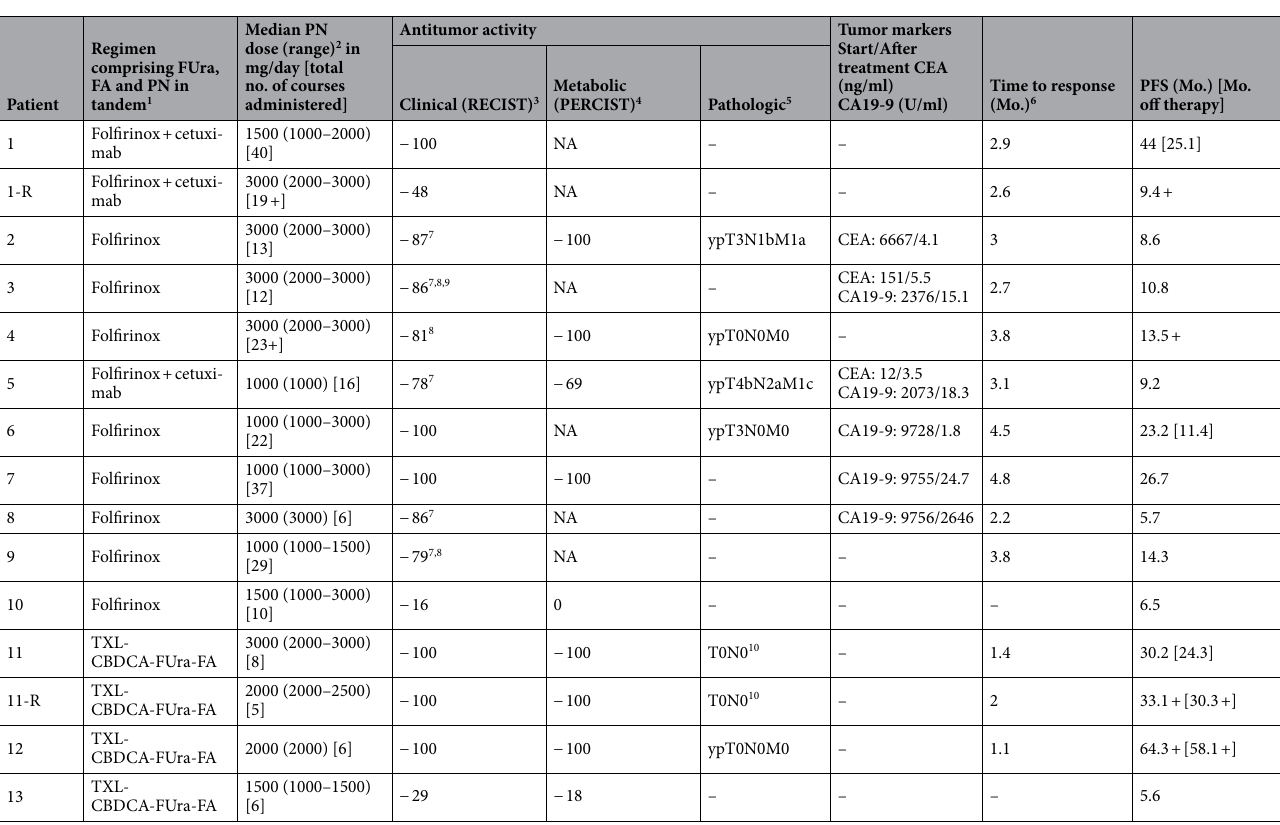
Table 2. Results of therapy in patients treated with regimens comprising 5-fluorouracil, folinic acid, and pyridoxine in tandem. 1 In patients treated with Folfirinox who required suspension of the L-OHP due to peripheral neuropathy, chemotherapy was pursued as Folfiri. 2 Range represents the intra-patient dose escalation of PN preceding each injection of FUra and FA given for a number of days defined by the chemotherapy regimen used. 3 Percent variation in sum of greatest diameters was assessed by CT scan, MRI, and endoscopic ultrasonography (EUS) imaging when required. For patients who attained a response accompanied by disappearance of most metastases, RECIST values were calculated by size comparison of persisting tumors at the time of assessment with these same tumors before treatment. 4 Percent variation of peak standard 18 FDG uptake value normalized by lean body mass (SUL peak ) of targets as measured by Positron Emission Tomography (PET) scan. 5 Pathologic response (AJCC) was assessed by colectomy and hepatectomy (Patients 2, and 5), colectomy and pulmonary resection (Patient 4), pancreaticoduodenectomy (Patient 6), endoscopic ultrasonography-guided biopsy (Patient 11), and esophagectomy (Patient 12) 6 Time to attain antitumor response, i.e. , a reduction in sum of diameters by ≥ 30%. Response was accompanied by disappearance of most liver, 7 lung 8 and/or bone 9 metastases present before treatment together with major reduction of all perceptible tumor foci. 10 Absence of residual tumor in EUS-guided esophageal and transmural node biopsies. R, second line therapy after relapse. NA, not